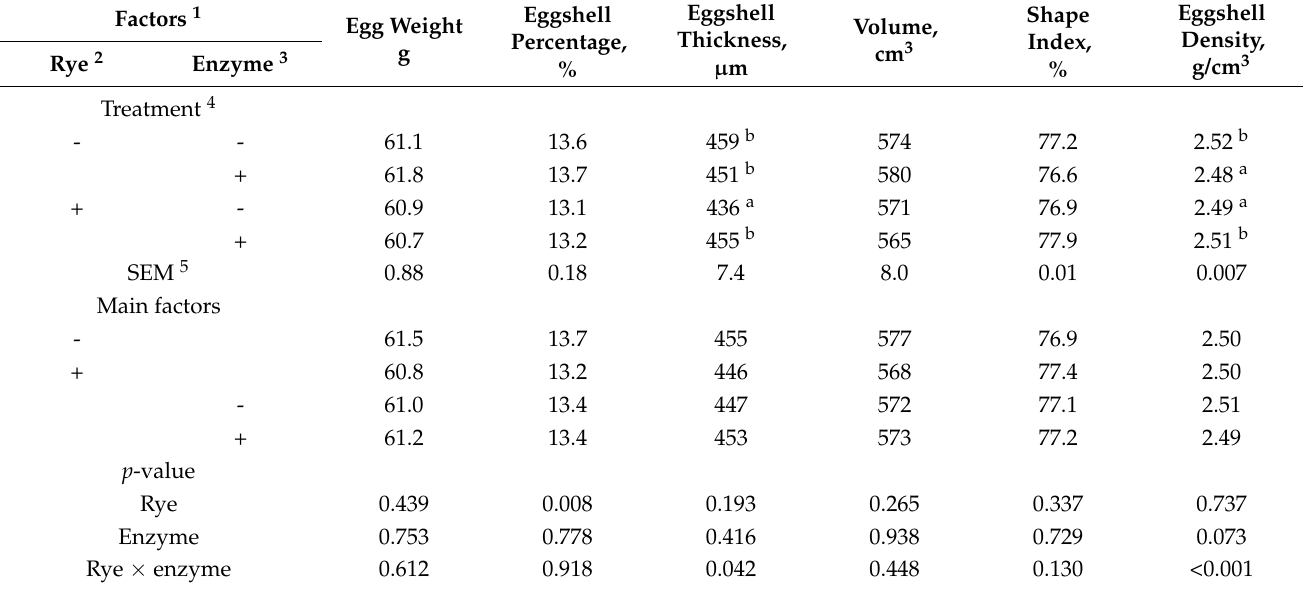
Table 2. Effect of dietary 25% rye inclusion and xylanase supplementation (200 mg/kg of feed) on external properties of eggshell at the end of the laying cycle.